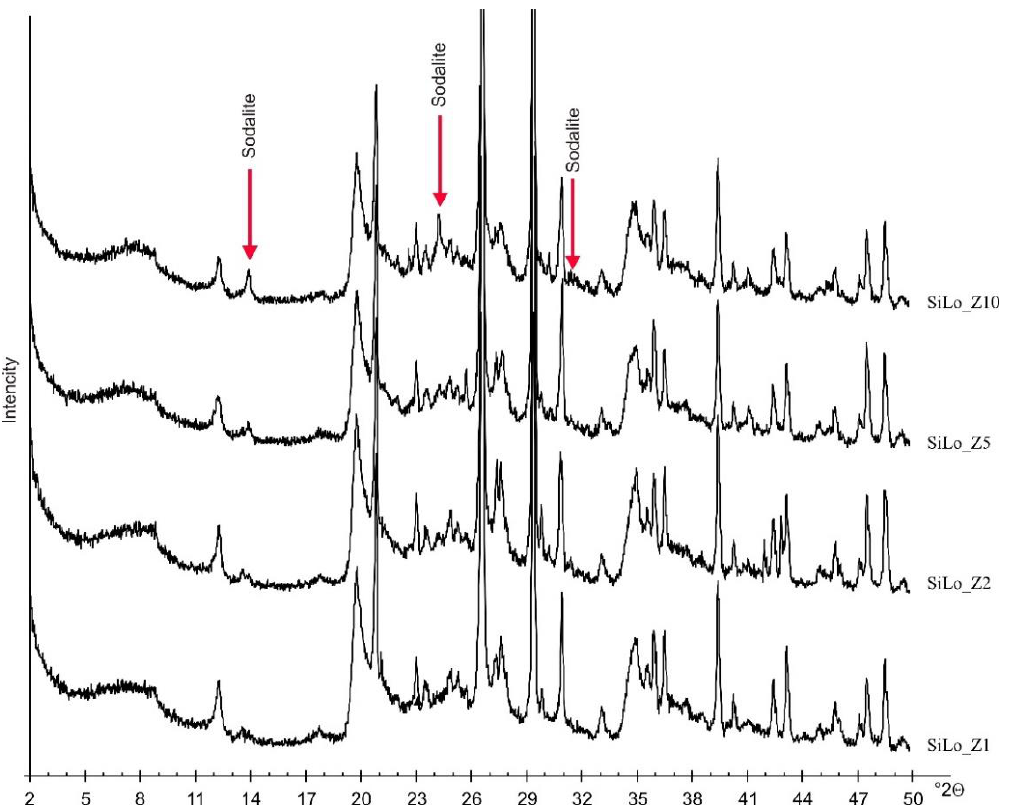
Figure 3. XRD patterns of soil without zeolite (SiLo_Zo), with 1% (SiLo_Z1), 2% (SiLo_Z2), 5% (SiLo_Z5) and 10% (SiLo_Z10) of zeolite.